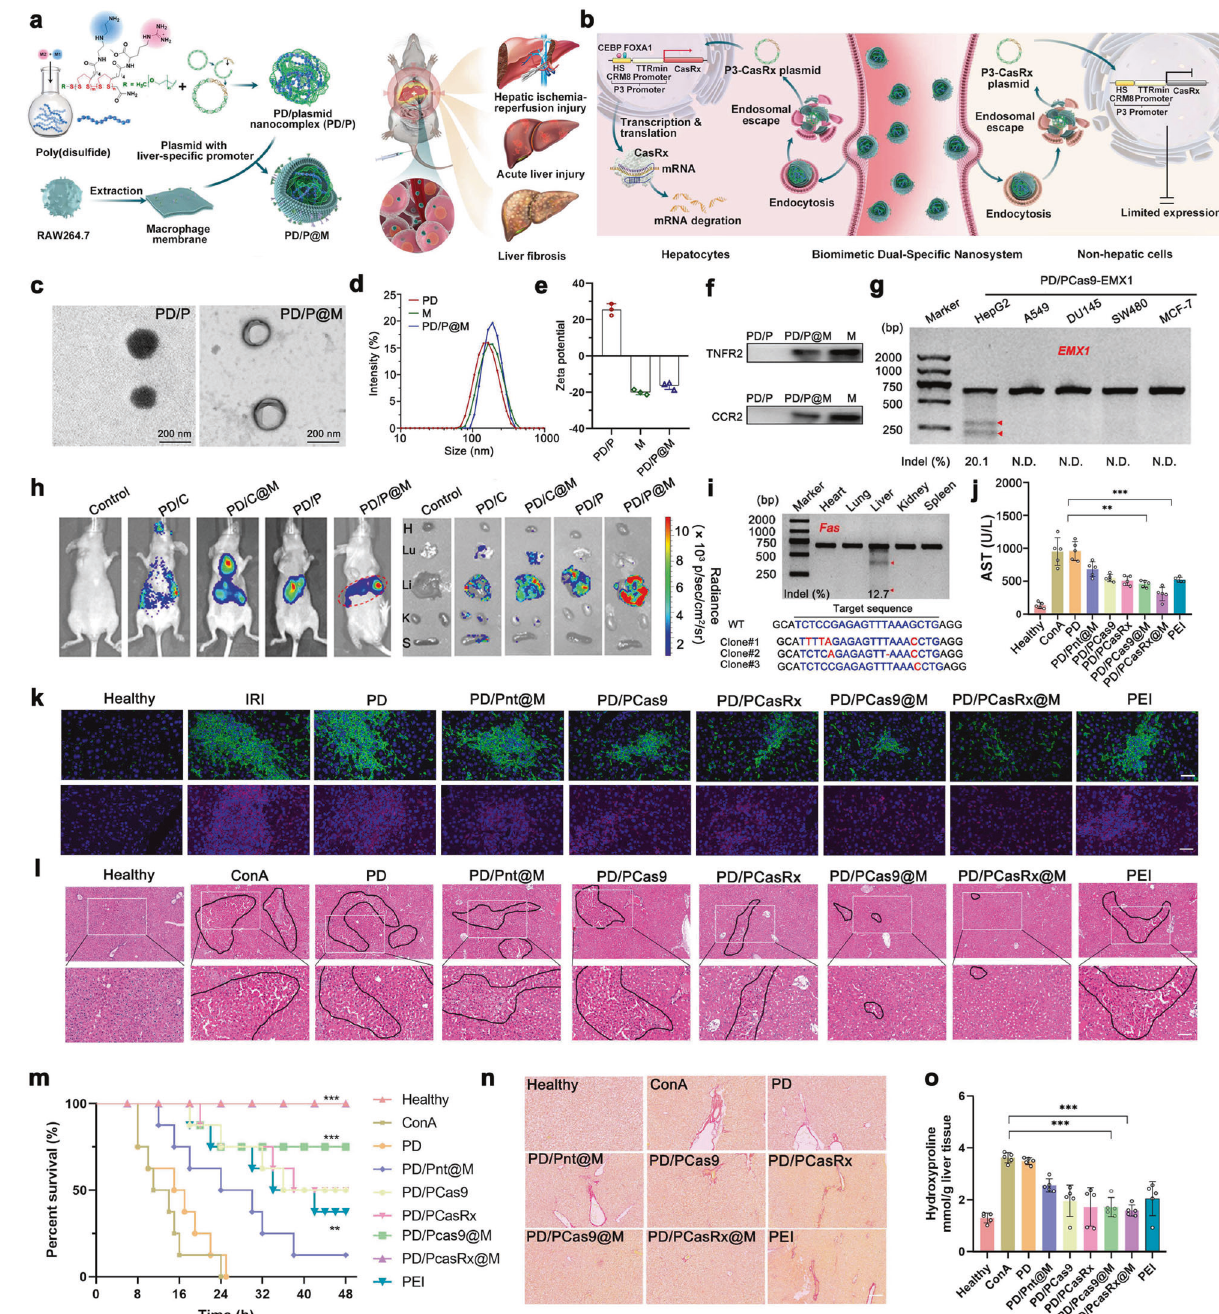
Fig. 1 a , b Schematic illustration of the biomimetic dual-speci fi c nanosystem for liver targeting and hepatocyte-speci fi c RNA editing for the treatment of hepatic ischemia reperfusion, liver fi brosis and acute liver injury. c Representative TEM image of PD/P and PD/P@M. Scale bar: 200 nm. Particle size ( d ) and ζ potential ( e ) of M, PD/P and PD/P@M complex analyzed by dynamic light scattering (DLS). Mean ± S.D., n = 3. f Characteristic protein bands of PD, PD/P@M, and M indicated by western blot. g Indel mutations of EMX1 locus detected by T7E1 assay after the indicated cells were transfected with PD/P-Cas9- EMX1 complexes. h Evaluation of in vivo luciferase expression of CMV-Cas9 (C) or P3-Cas9 (P) plasmid with luciferase tag in BALB/c mice and dislodged organs. H, heart; Lu lung; Li, liver; K, kidney; S, spleen. i Indel mutations of Fas locus in different organs as detected by T7E1 assay and Sanger sequencing of the liver tissue. j The serum AST level after the indicated treatment of mice with hepatic ischemia-reperfusion injury. k Immuno fl uorescence staining of the liver samples after the indicated treatment. Anti-F4/80 antibody (green) was used for monocyte/macrophage marker, anti-Ly6G antibody (red) was used for neutrophils marker, and DAPI (blue) for nuclear staining of liver tissues from each group. Scale bar: 50 µm. l The H&E staining of the liver from mice with acute liver injury after the indicated treatment. The region of the black line denotes the accumulation of blood cells. Scar bar, top panel, 200 µm; scar bar, lower panel, 100 µm. m Survival rates of mice after the treatment. ( n = 8), Log-rank test (Mantel-cox test). n Liver sections were stained for sirius red to assess the degreecollagen deposition and fi brillar collagen. Scale bar: 200 µm. o Hepatic hydroxyproline from the liver fi brosis mice administered with complexes. All of the data analyzes as mean ± S.D., n = 5. One-way ANOVA with a Tukey ’ s post-hoc test. * P < 0.05; ** P < 0.01 *** P < 0.001